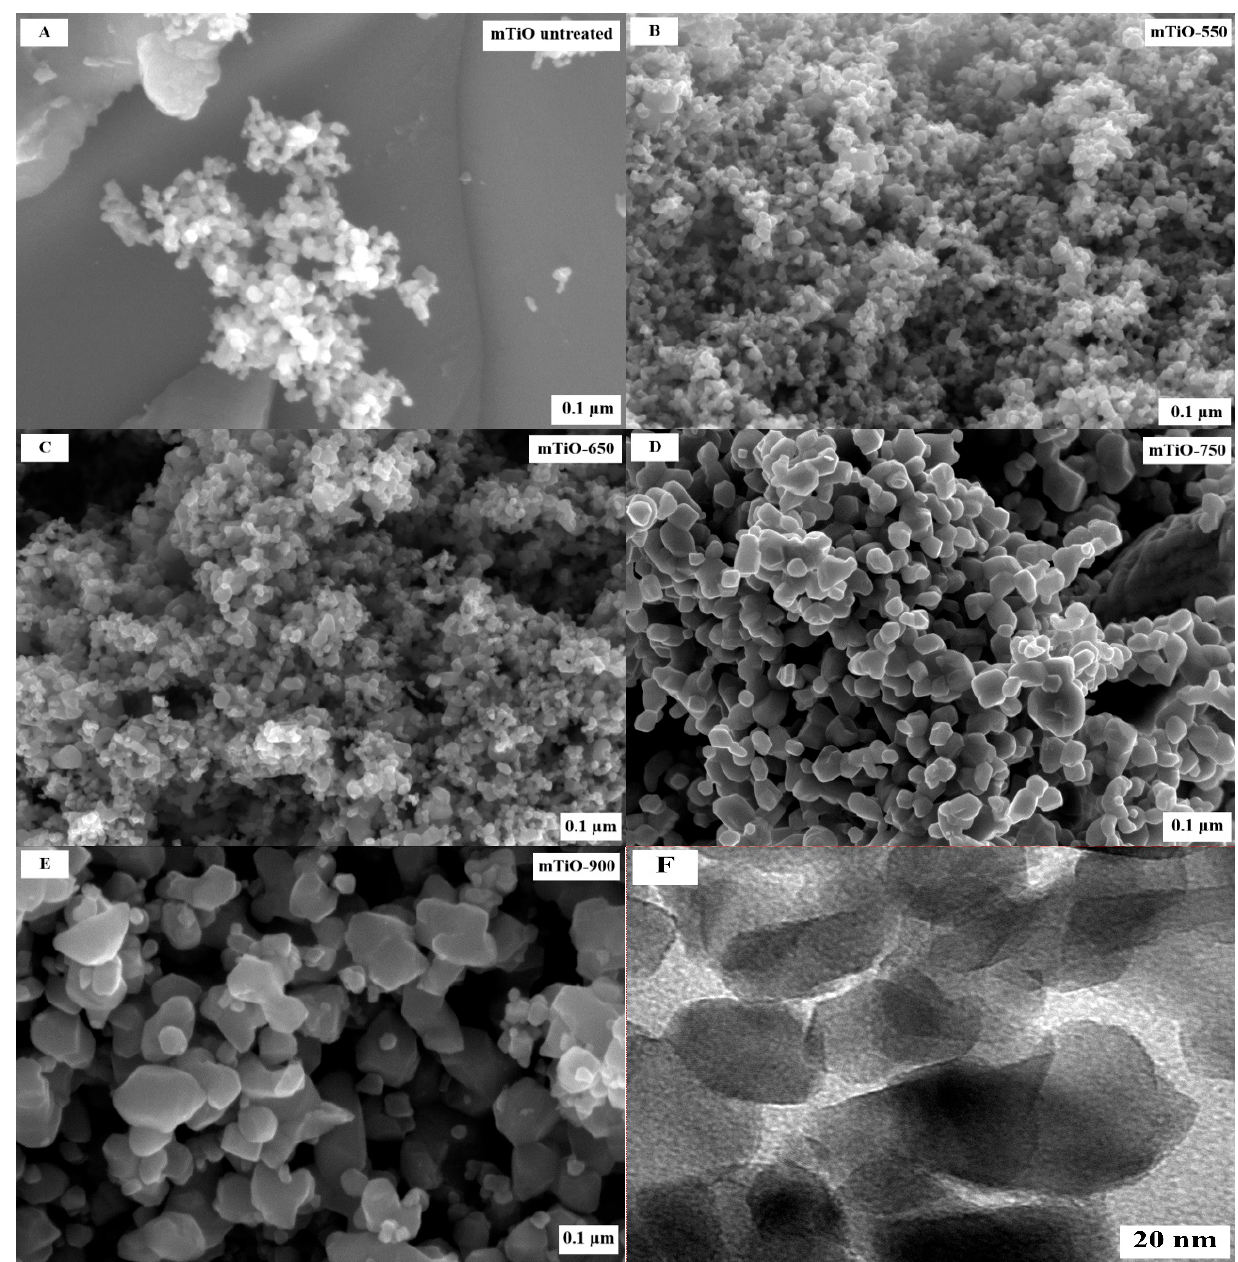
Figure 9. SEM images of mTiO untreated ( A ), mTiO-550 ( B ), mTiO-650 ( C ), mTiO-750 ( D ), mTiO-900 ( E ) and TEM image of mTiO-650 ( F ).